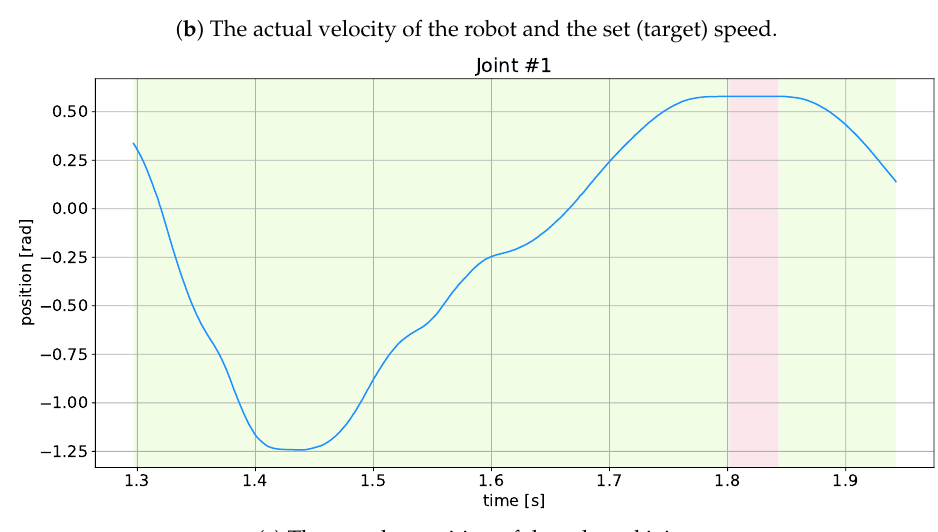
( c ) The angular position of the selected joint. Figure 2. Example of 1000 samples (about 0.7 s) of measurement data for motor/joint # 1 (bright red stripe show the stop period while light green shows